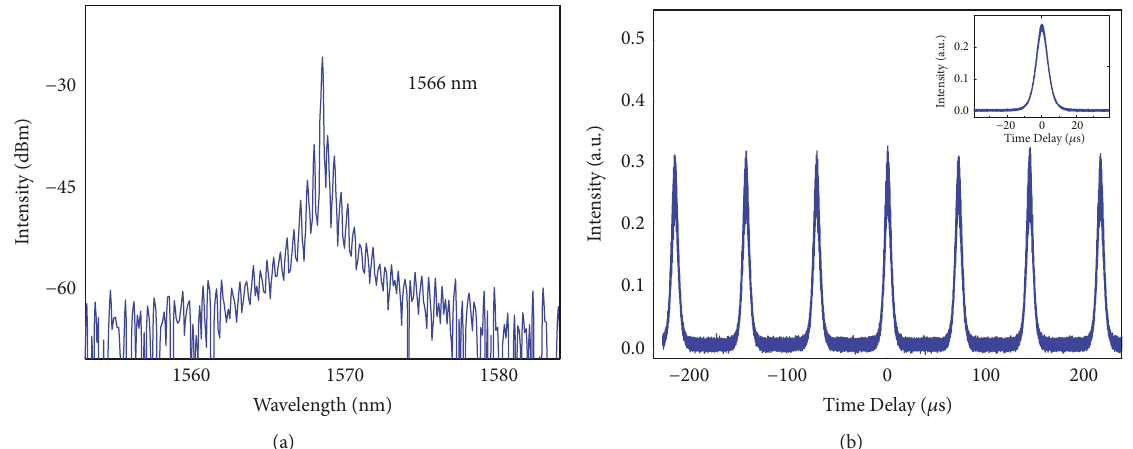
Figure 4: (a) The spectra of the Q-switched fiber laser based on MoTe 2 . (b) The pulse train and the profile of the Q-switched pulse shown inset.